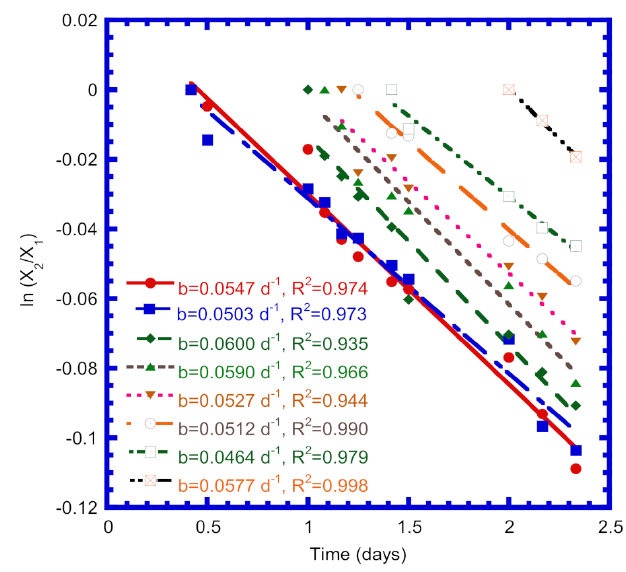
Figure 5. Batch experiments to determine the decay constants ( b